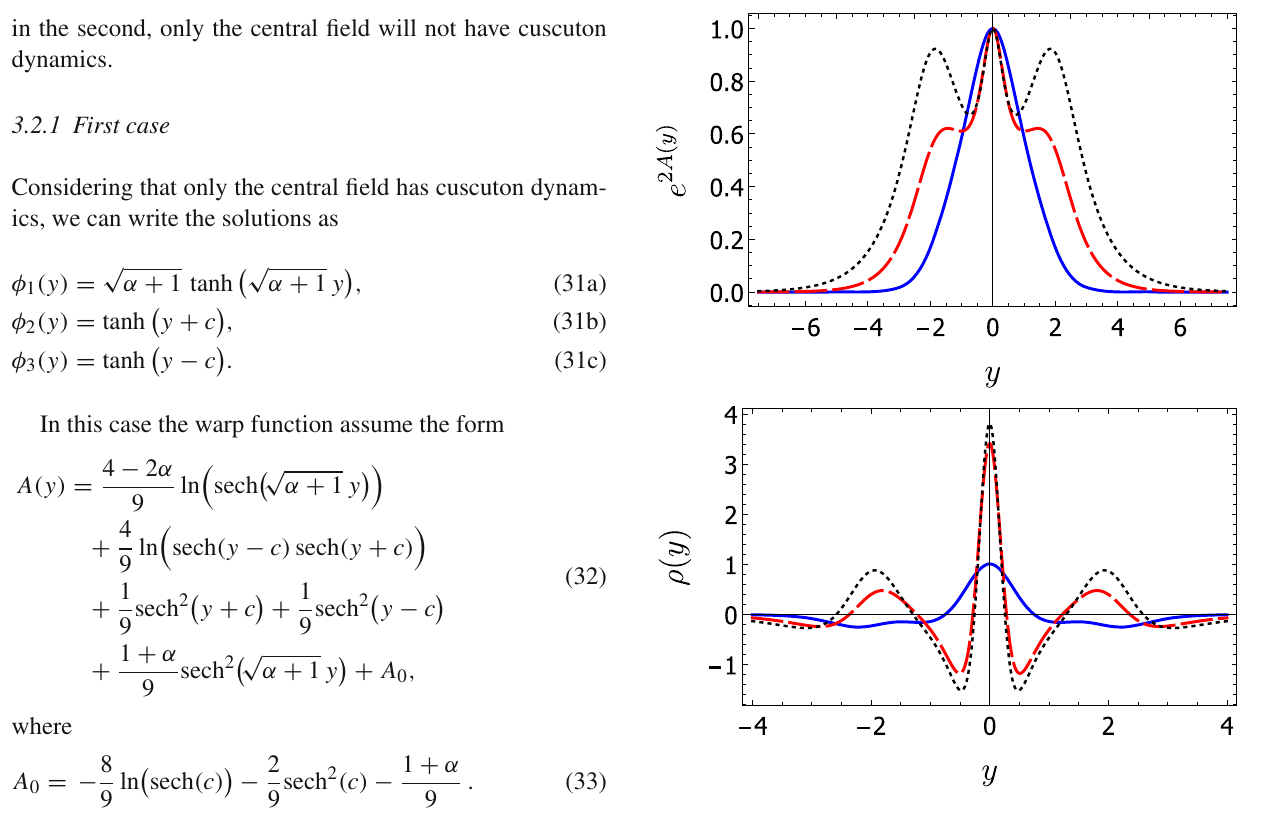
Fig. 3 Warp factor (top panel) and energy density (bottom panel) depicted for c = 2 and α = 0 (solid-line), α = 2 . 4 (dashed-line) and α = 2 . 8